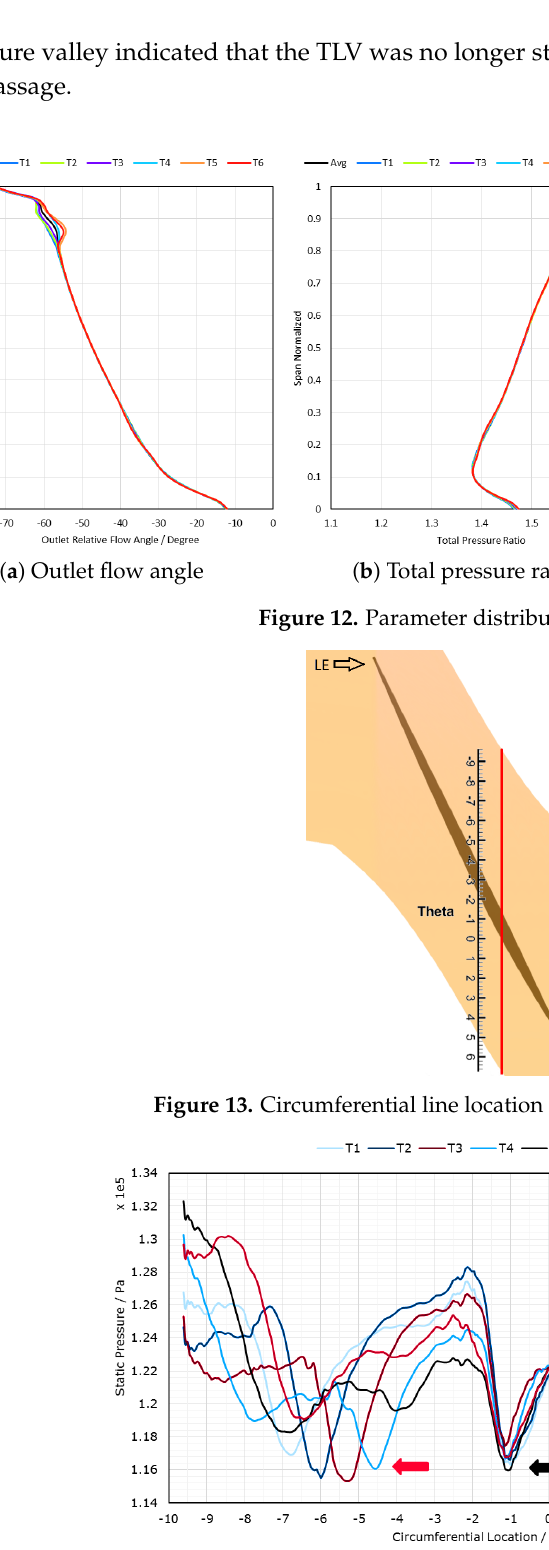
Figure 14. Circumferential distribution of casing pressure at a certain axial